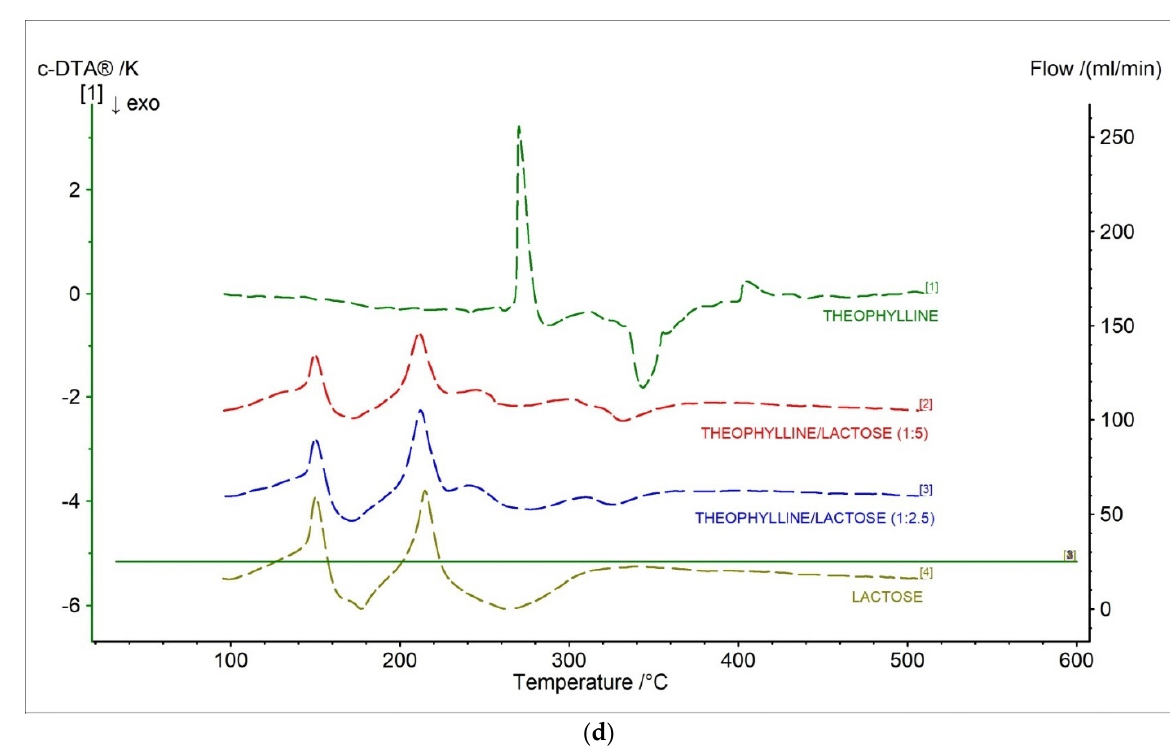
Figure 8. ( a ) TG, ( b ) DTG, ( c ) D2TG and ( d ) c-DTA curves for theophylline standard, theophylline, and lactose mixtures in different ratios (1:5, 1:2.5) and lactose monohydrate. Table 4. Characteristic parameters of TGA, and D2TG curves of the tested samples. Table 6. Characteristic parameters c-DTA of the tested